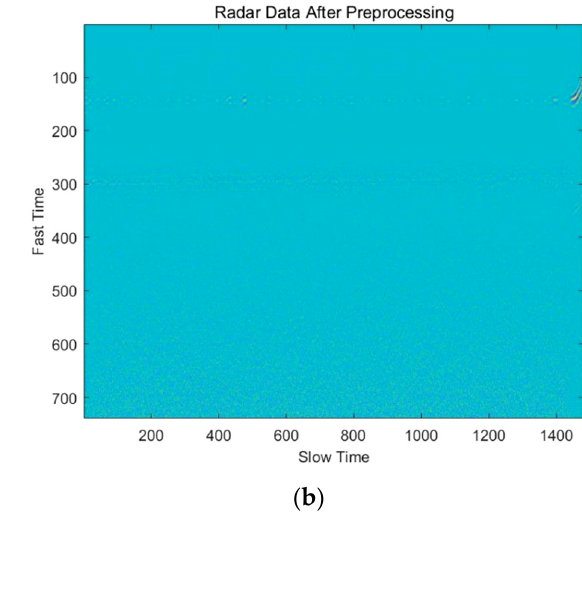
Table 6. Settings of different experimental groups.